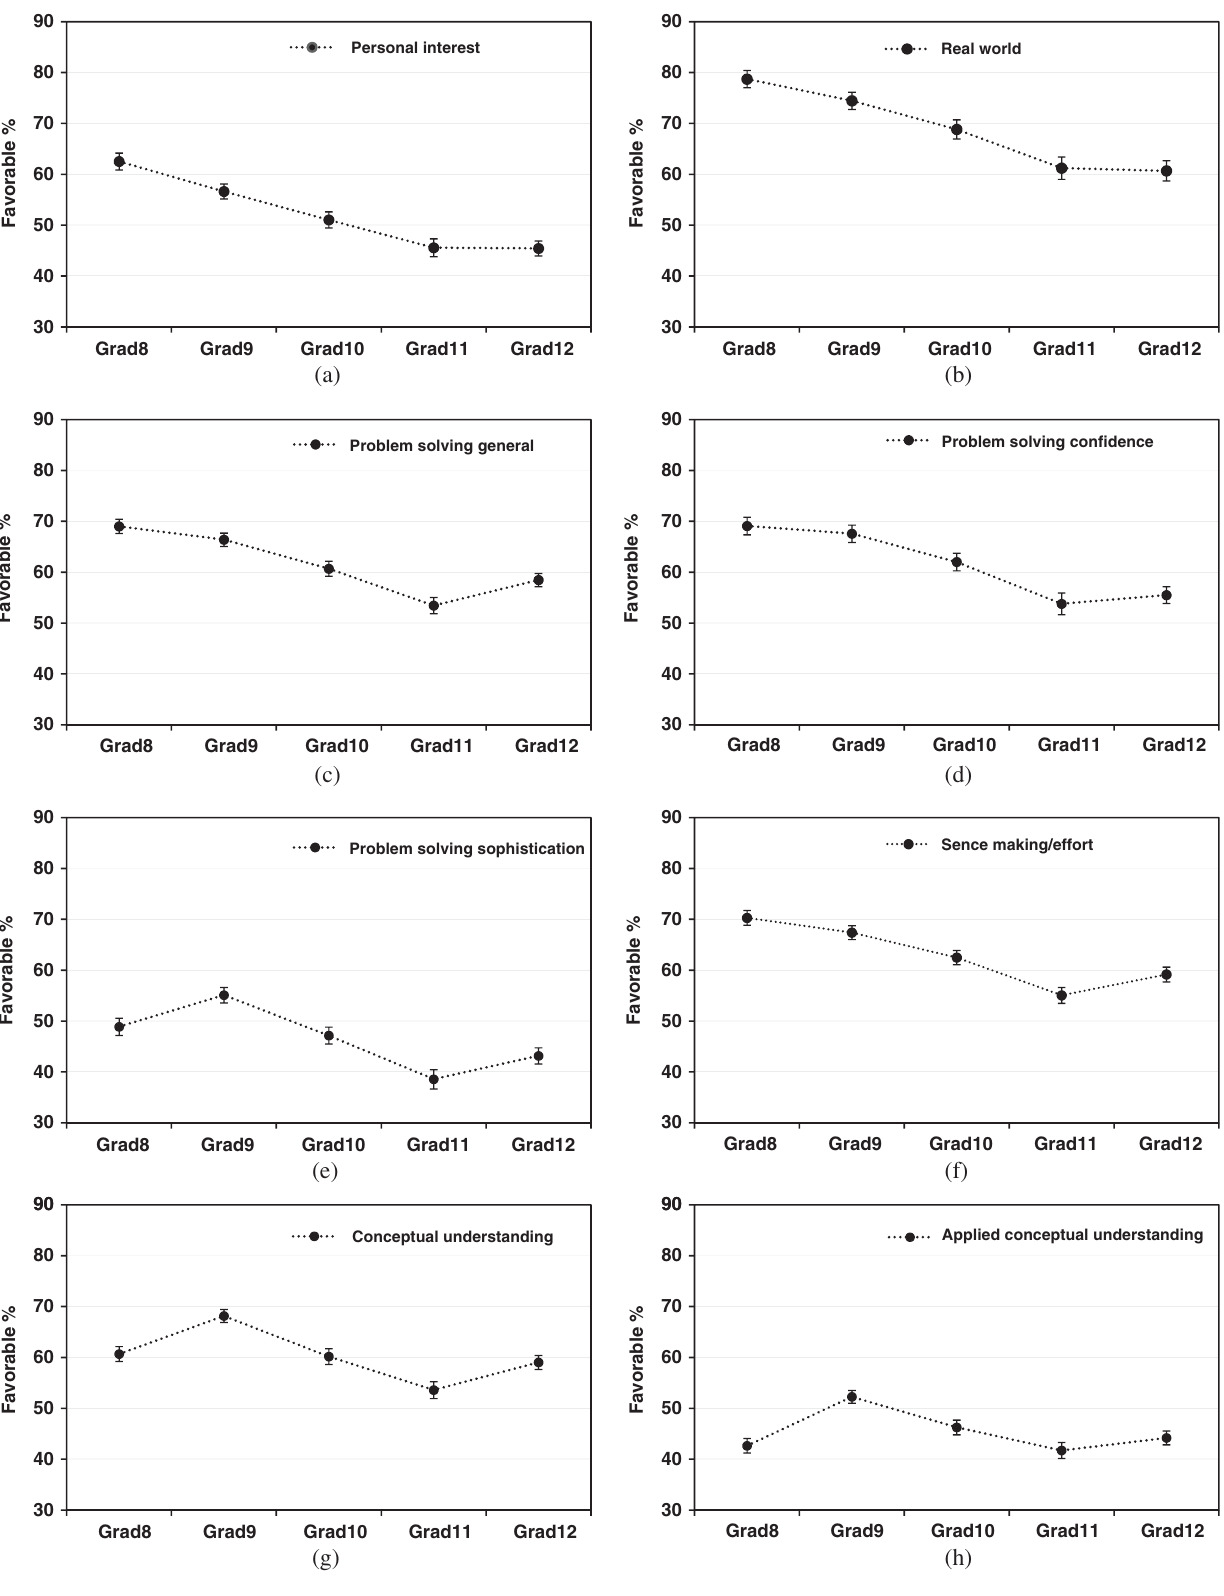
FIG. 3 (color online). Student favorable percentages on eight CLASS categories across grade levels: (a) personal interest; (b) real world connection; (c) problem solving general; (d) problem solving confidence; (e) problem solving sophistication; (f) sense making; (g) conceptual understanding; and (h) applied conceptual